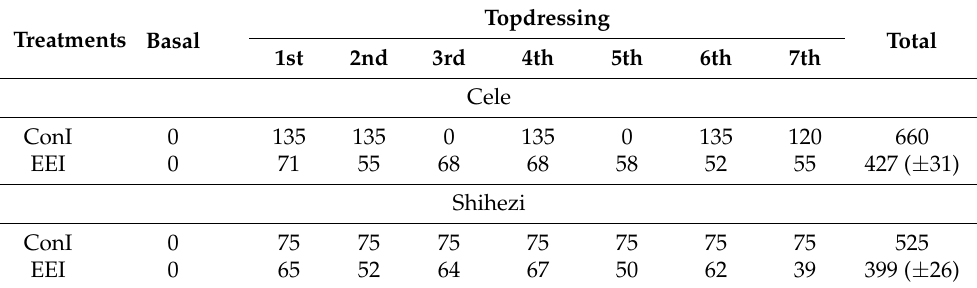
Table 2. Irrigation amount (mm) under different irrigation managements of two experimental sites. Treatments Basal